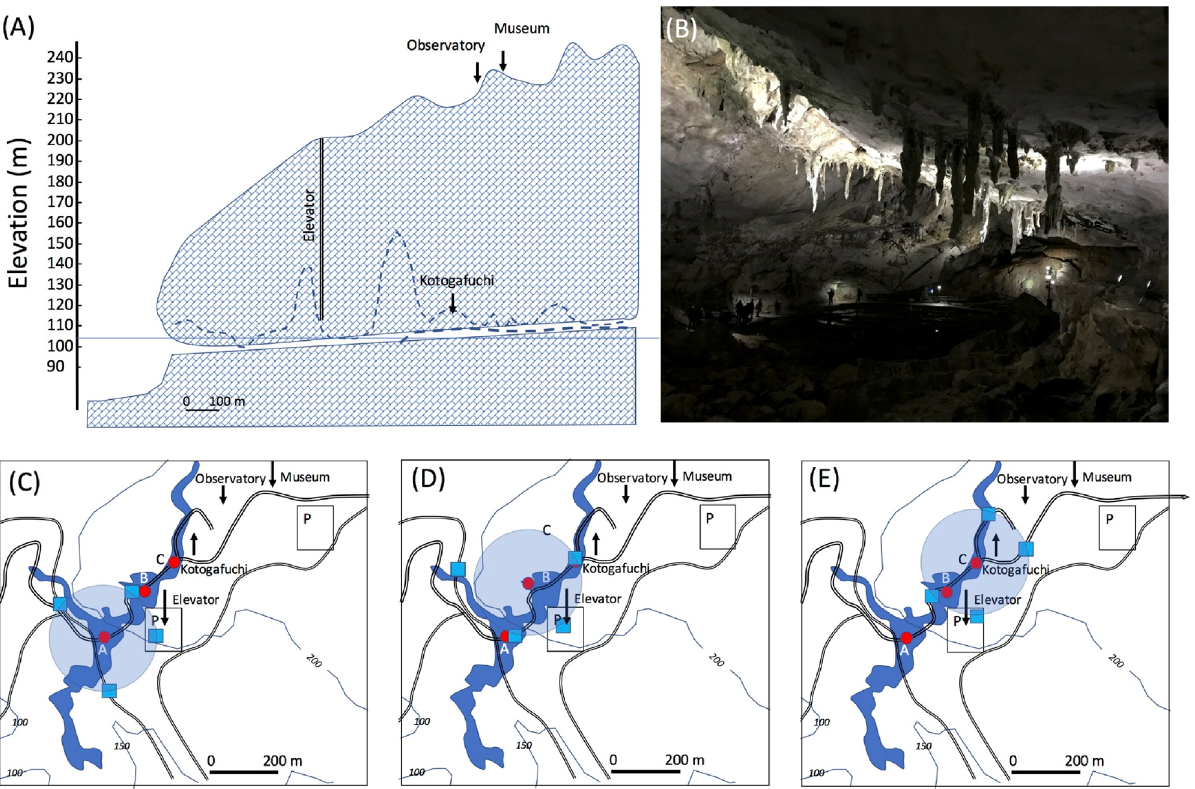
Figure 7. Side ( A ), inside photograph ( B ) and top views ( C , D , E ) of Akiyoshido cave. The dashed line indicates the actual geometry of the cave, but a cylindrical cave (empty near horizontal space underneath the overburden) was assumed in this work ( A ). In the top views, the locations of the reference detectors (blue filled squares) and receiver detectors (red filled squares) are shown. The cave region is indicated by the region filled in with darker blue. The locations of the reference detectors (blue filled squares) and receiver detectors (red filled squares) are also shown. Blue filled circles indicate the region within 150 m from the receiver detector. The double lines and the labels "P" respectively indicate roads and parking lots. The contour lines showing elevations are also shown. HKMT took the photograph. HKMT drew the map and the images with Microsoft PowerPoint software and holds the